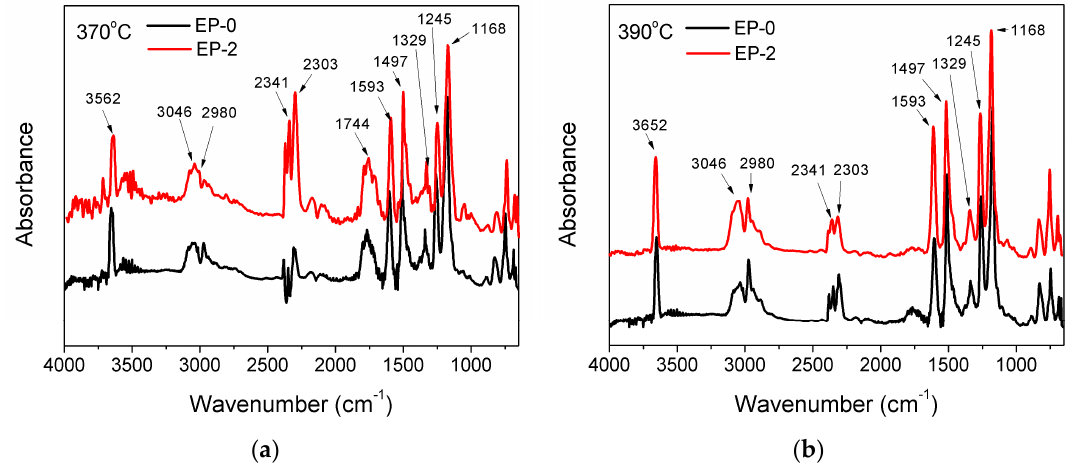
Figure 5. TGA–FTIR curves of EP-0 and EP-2 at ( a ) 370 °C and ( b ) 390 °C.